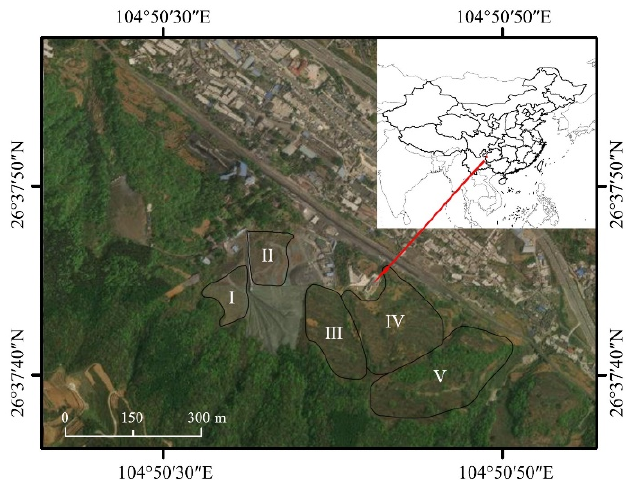
Figure 1. Location of the study area. Table 1. Basic situation of five coal gangue mountains in the year 2015. Table 1. Basic situation of five coal gangue mountains in the year